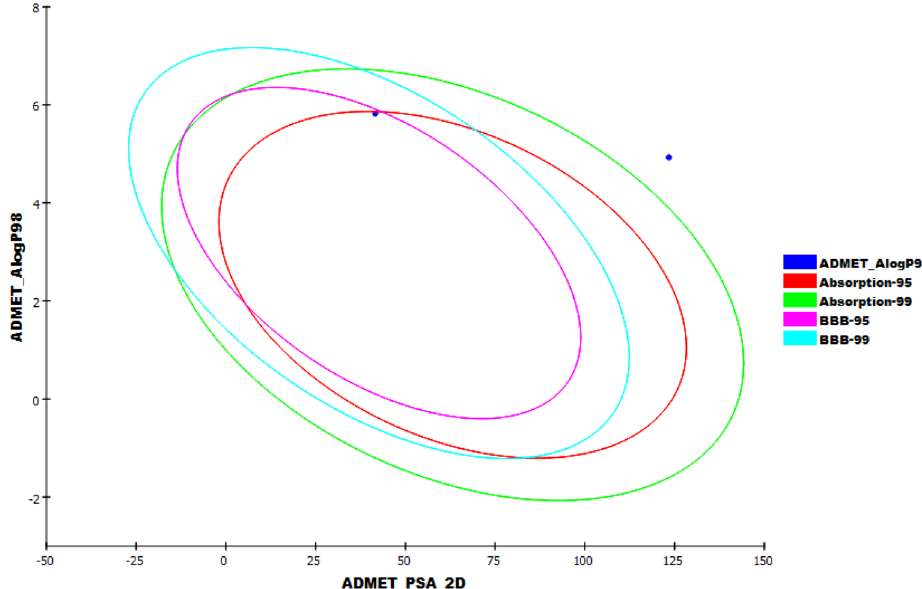
Figure 7. The expected ADMET study.